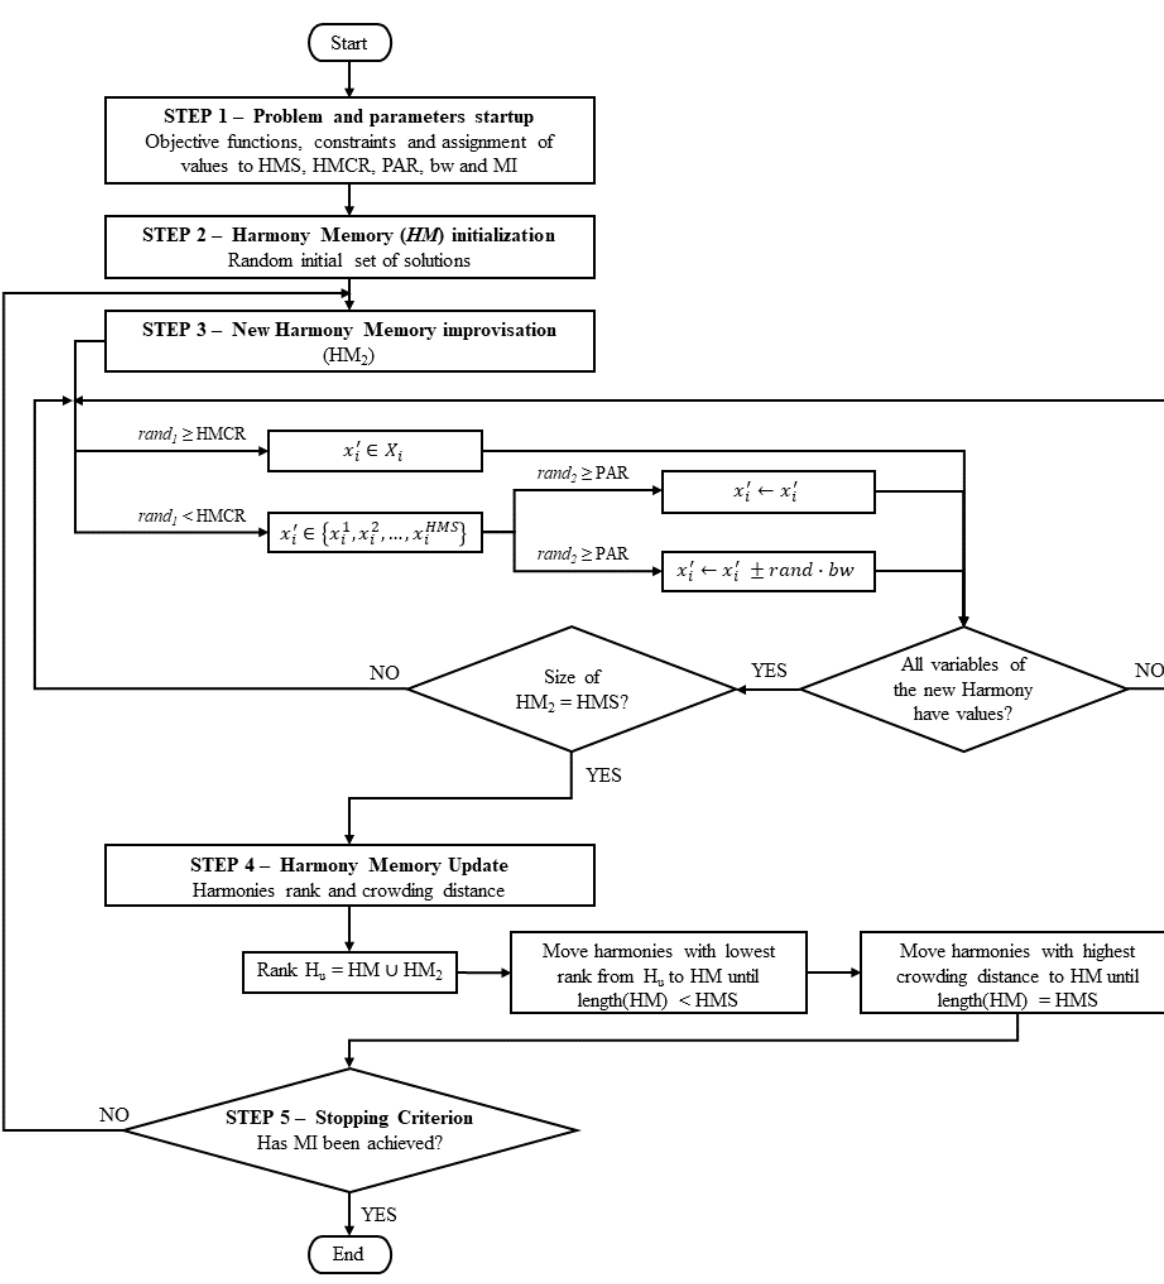
Figure 1. Multiobjective Harmony Search algorithm.